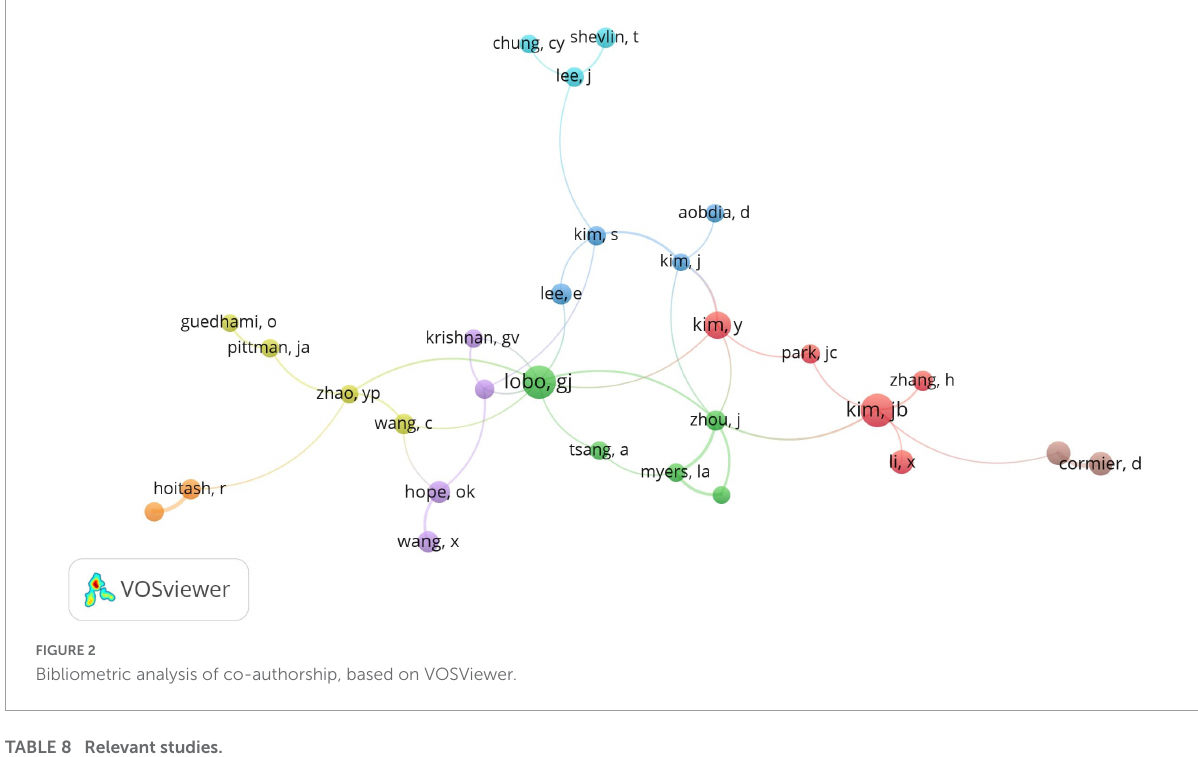
TABLE 8 Relevant